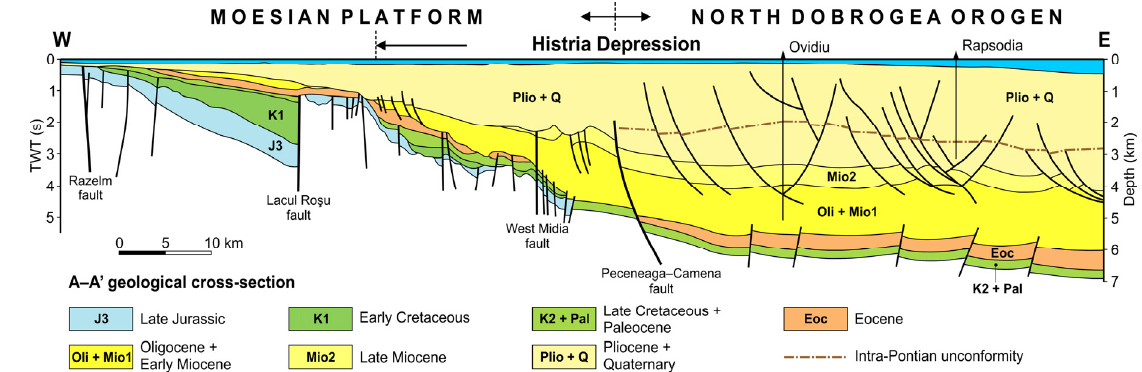
2. Figure 2. A–A’ Geological cross-section with W–E direction through the Romanian Black Sea shelf area, based on seismic reflection and well data (redrawn and modified from